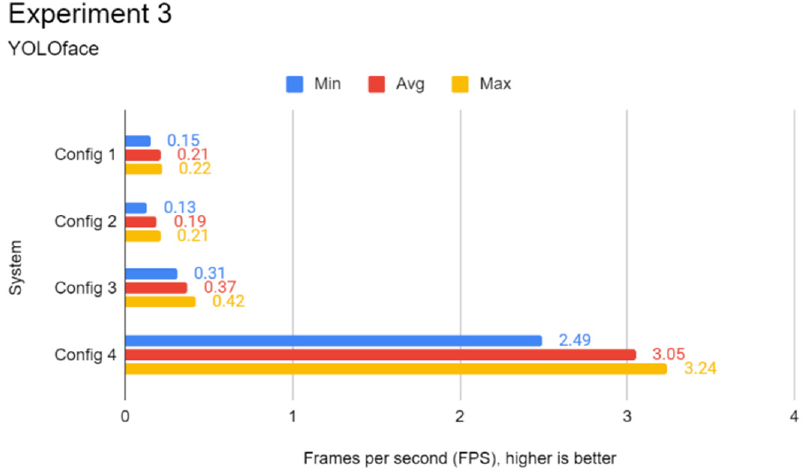
Figure A8. Bar chart FPS results for all systems running MTCNN for face detection in Experiment 3.